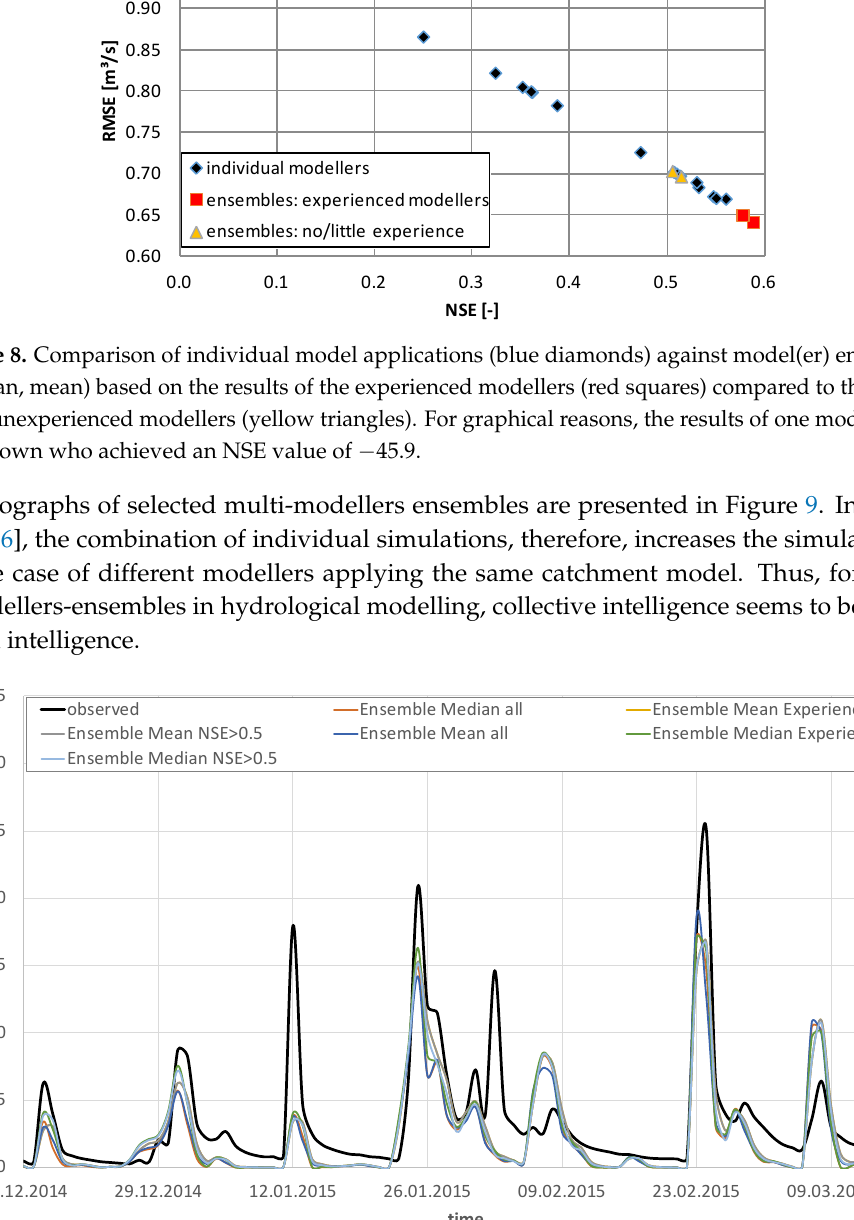
Figure 7. Comparison of individual model applications (blue diamonds) against model(er) ensembles (median, mean) based on all models (red squares) and on all models achieving satisfactory model results (yellow triangles) according to [25]. For graphical reasons, the results of one modeller are not shown who achieved an NSE value of − 45.9.